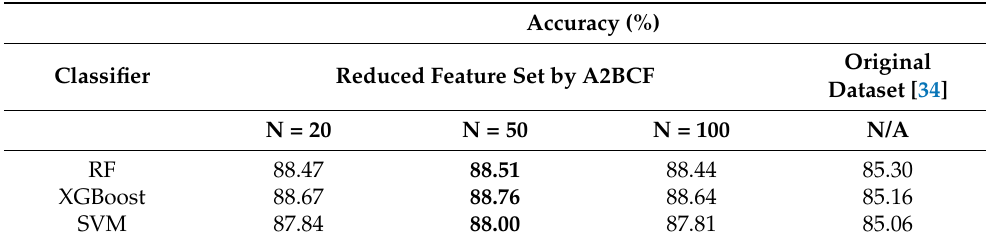
Table 1. Comparison of A2BCF under different population sizes with a previous